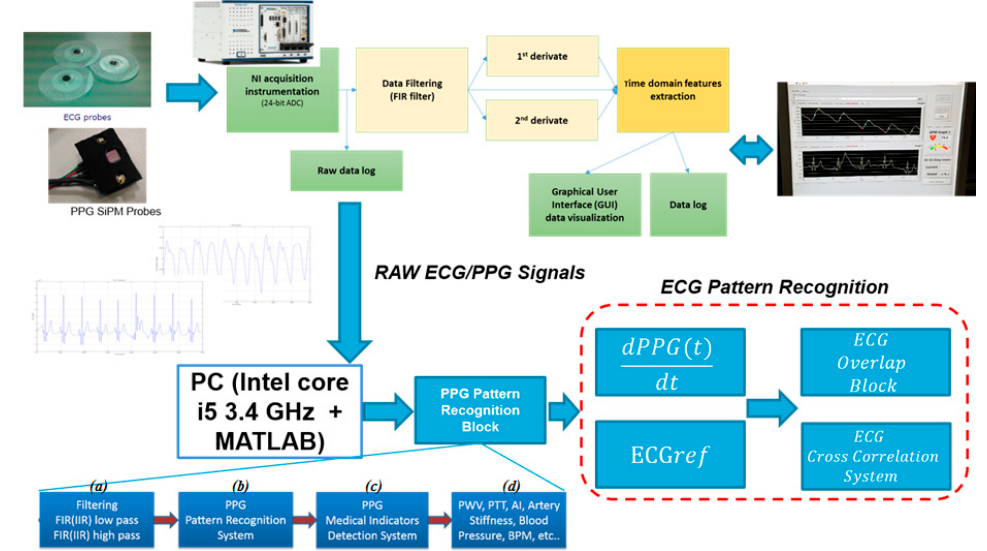
Figure 12. Overall System Architecture of the PPG/ECG combo system with Patter Recognition Pipelines. The figure shows detailed about PPG recognition stage (blocks ( a – d )) and ECG PR blocks (ECG Pattern Recognition).